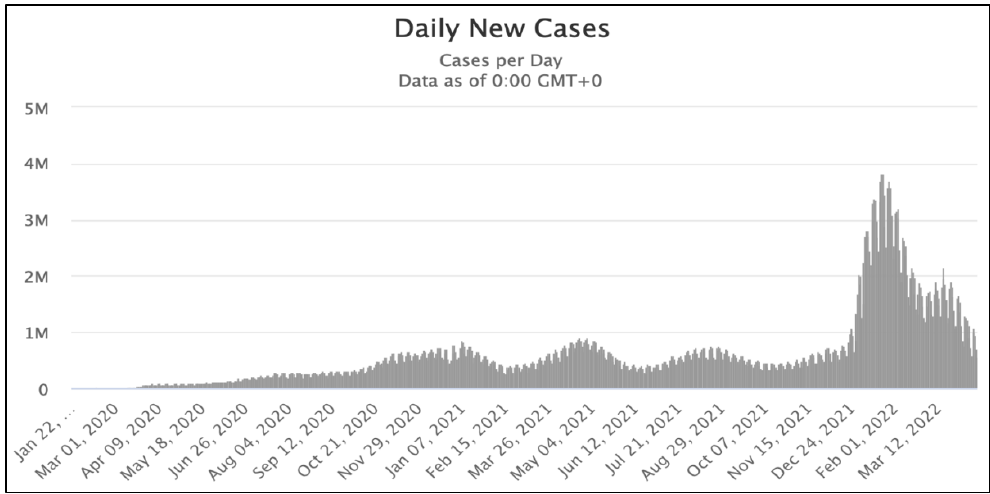
Figure 1. Daily Covid-19 New Cases from January 22 nd until March 12 th 2022